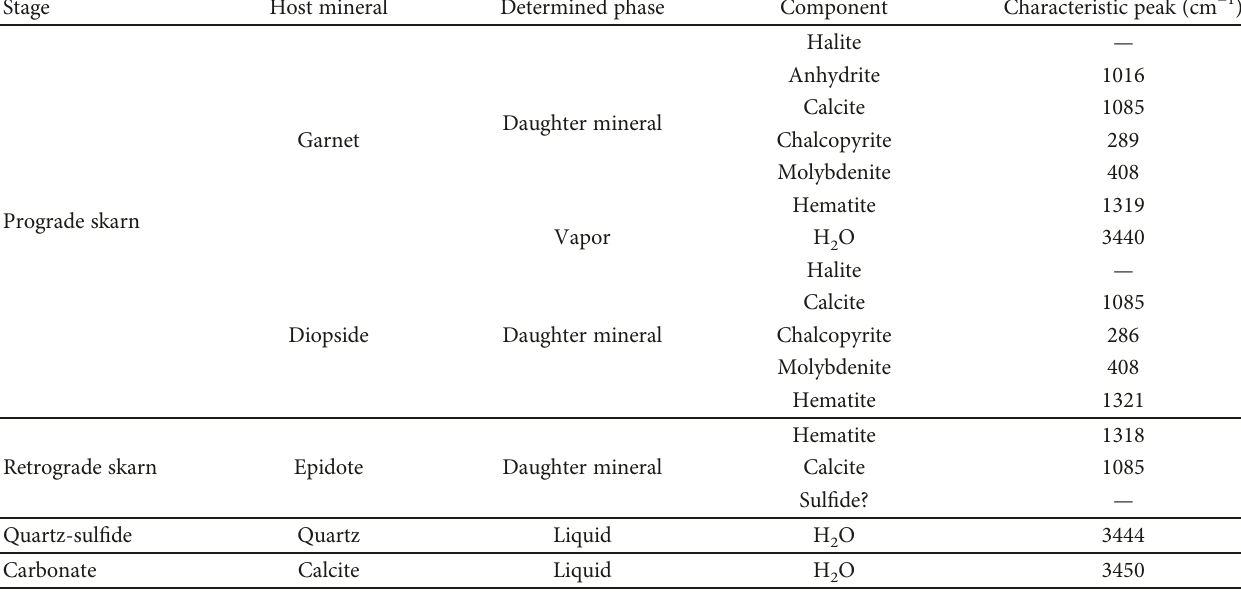
Table 1: Summary of components of fl uid inclusions by laser Raman spectroscopic analyses and petrographic